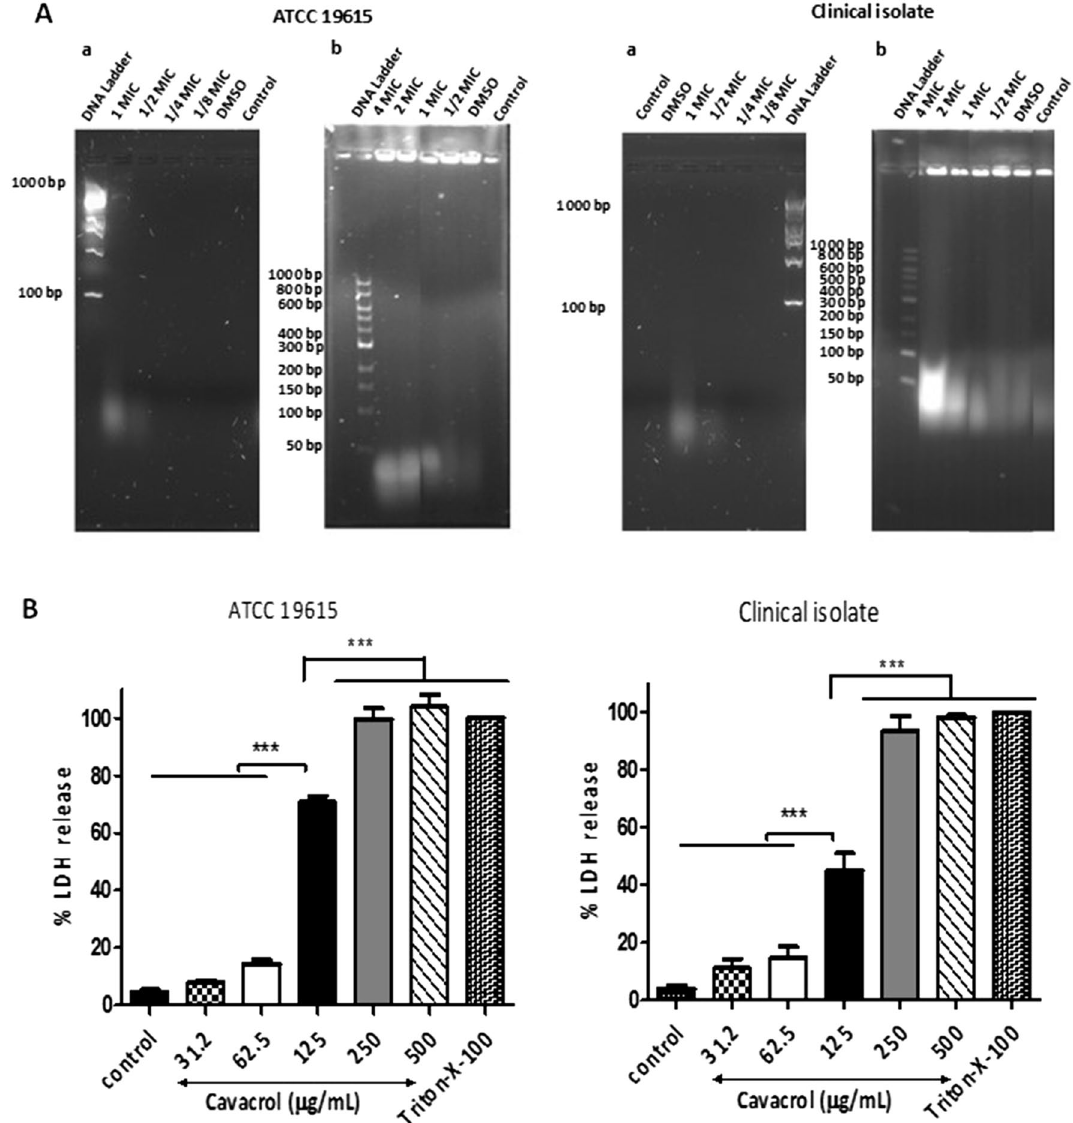
Figure 4. Carvacrol induces cytoplasmic content leakage. ( A ) Carvacrol causes the leakage of cytoplasmic nucleic materials from Streptococcus pyogenes in a concentration-dependent manner. Agarose gel (1%, w/v) electrophoresis and gel red staining of leaked nucleic acid from cell suspensions (1 × 10 6 , OD = 0.02) of ATCC 19615 and clinical isolate strains (a) exposed to MIC (125 μg/mL), 1/2 MIC, and 1/4 MIC of carvacrol or vehicle control (0.25% DMSO) over 24 h. 1 kb ladder as reference. (b) Agarose gel (0.8%, w/v) electrophoresis and ethidium bromide staining of genomic DNA recovery of the DNA by ethanol precipitation from bacteria suspension (OD = 0.6) of followed by 2 h carvacrol treatment. Carvacrol concentration is adjusted to the high bacterial density as MIC = 3750 μg/mL and 1 kb ladder were used as a reference. ( B ) Carvacrol causes leakage of lactate dehydrogenase (LDH) from ATCC 19615 and a clinical isolate of Streptococcus pyogenes. Overnight incubated cells were treated with different carvacrol or vehicle (0.25% DMSO) for 4 h. A standard lysis buffer (9% Triton X-100) was included as a positive control and was defined as 100% LDH release. The carvacrol- induced LDH release into culture media was measured using the Promega LDH Cytotoxicity Assay Kit. Data expressed as % LDH release and represented mean ± SE (n = 3), ***P < 0.001, compared among means (ANOVA, Tukey’s test). ( C ) Carvacrol does not cause the release of LDH from cultured human tonsil epithelial cells. The seeded human tonsil epithelium cells (TonEpiCs) for 24 h were treated with different concentrations of carvacrol or DMSO vehicle for 4 h. A standard lysis buffer was included as a positive control and defined as 100% LDH release. The carvacrol-induced LDH release into cell supernatant was measured using the Promega LDH Cytotoxicity Assay Kit. Data expressed as % LDH release and represented mean ± SEM (n = 3), ***P < 0.001, *P < 0.05, compared among means (ANOVA, Tukey’s